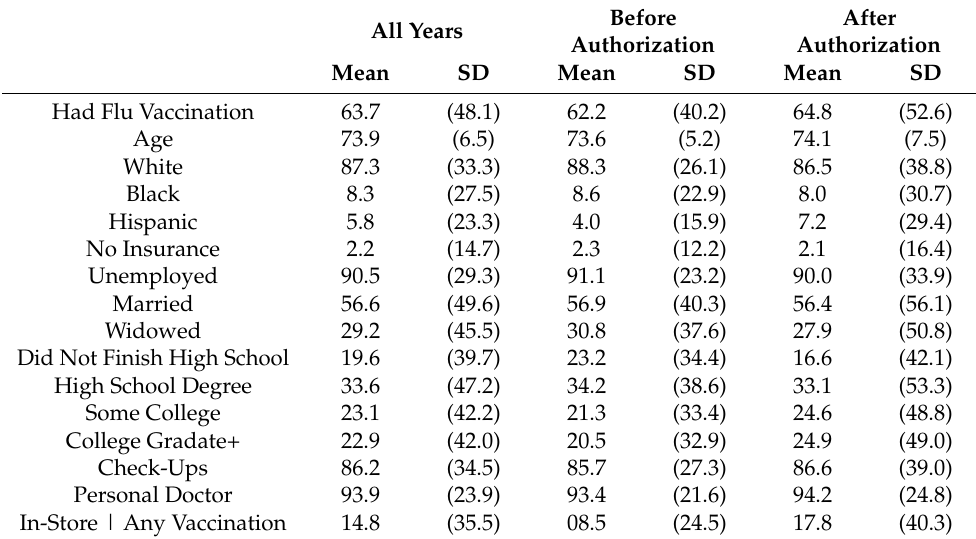
Table 1. Summary statistics from BRFSS data for adults age